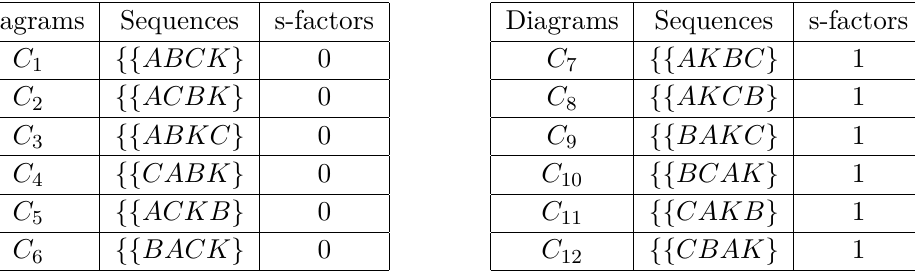
Table 15. Normal ordered diagrams of Cweb W (2 , 1)